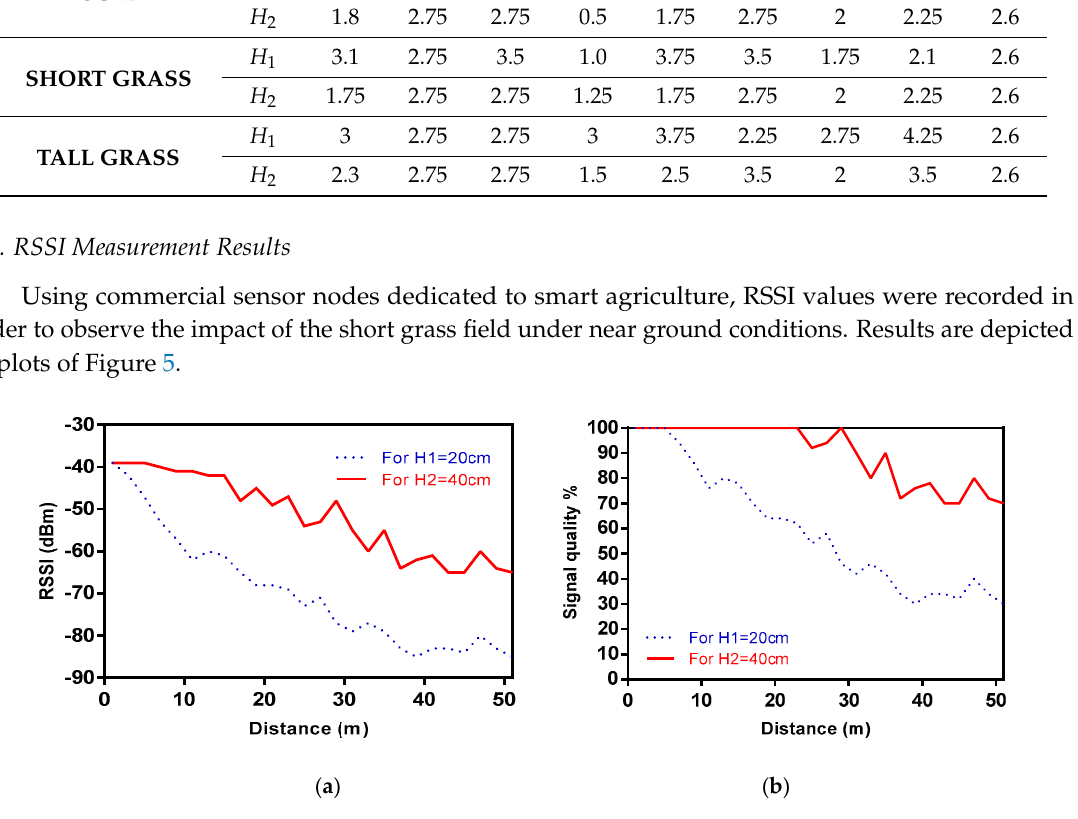
Figure 5. Difference at (cid:1834) (cid:2869) and (cid:1834) (cid:2870) between ( a ) RSSI values; ( b ) radio link quality.